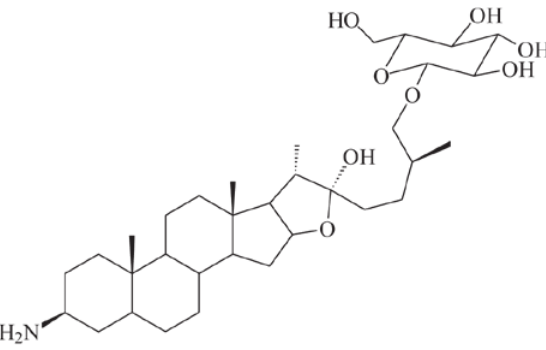
Fig. 1 - Representative structure of jurubine. Our group has isolated the compound from Solanum paniculatum